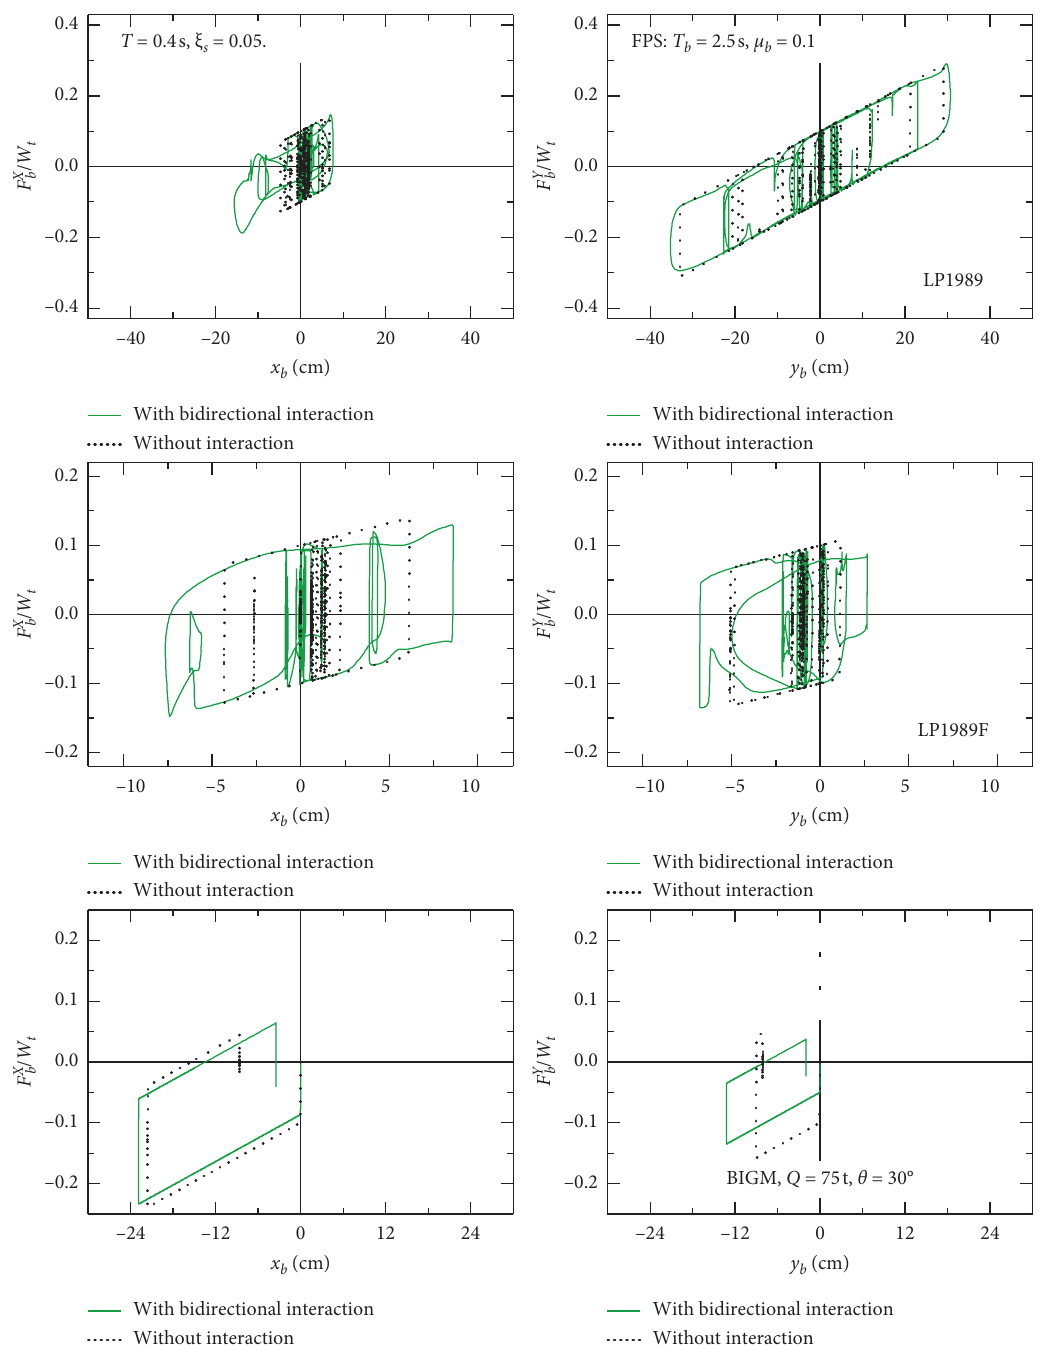
Figure 6: Force-deformation curve of the FPS system with and without the consideration of bidirectional